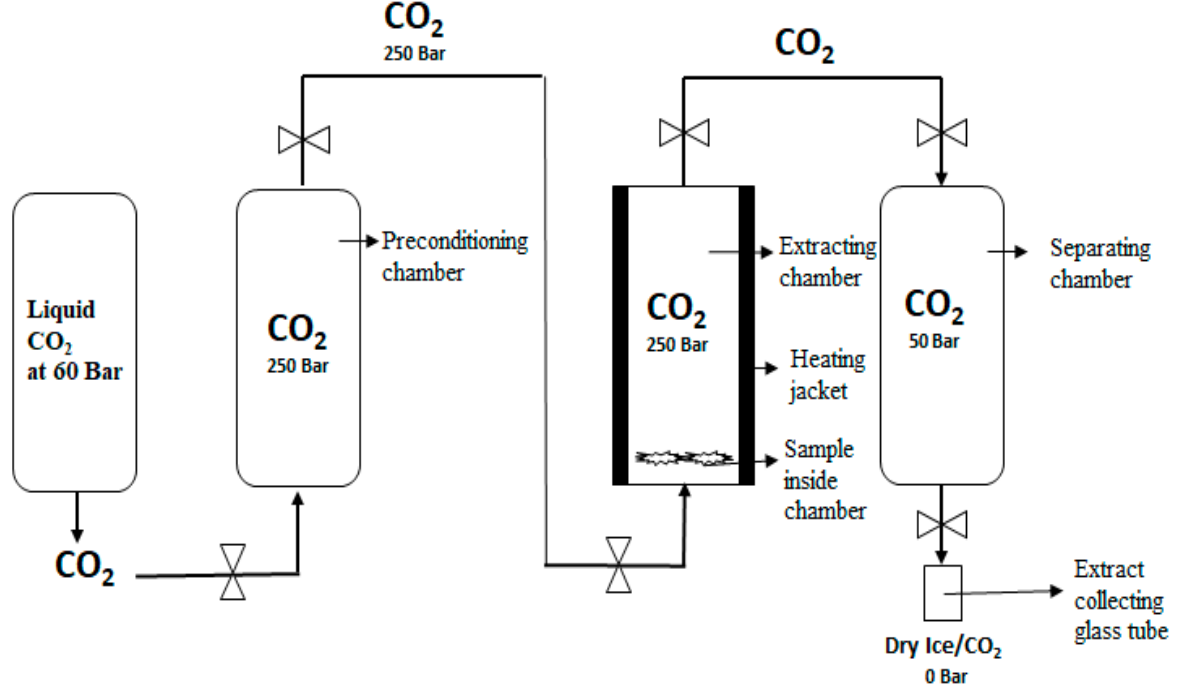
Figure 1. Schematic representation of the supercritical extraction Helix unit.